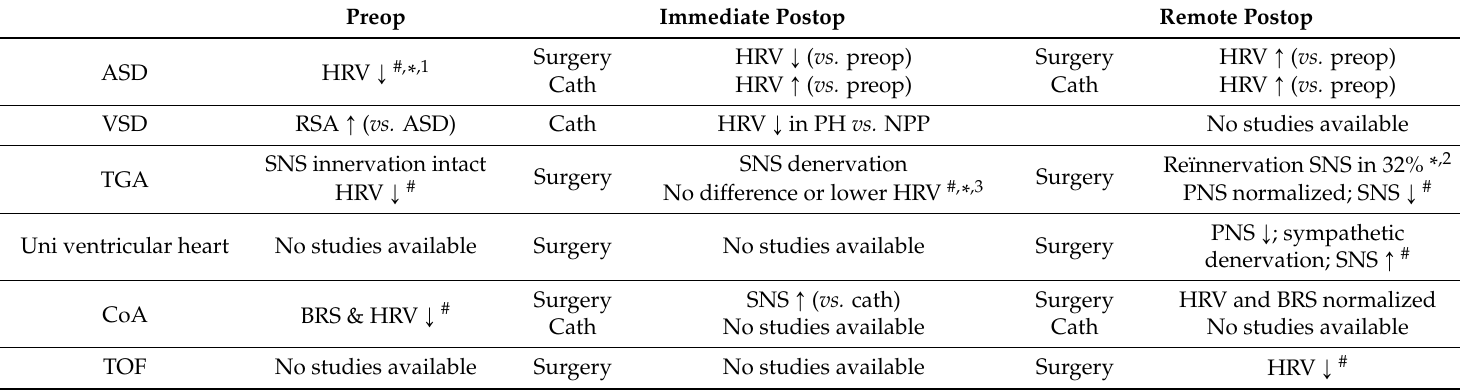
Table 2. Summary of preoperative, immediate postoperative and long term postoperative findings per congenital heart disease (CHD).